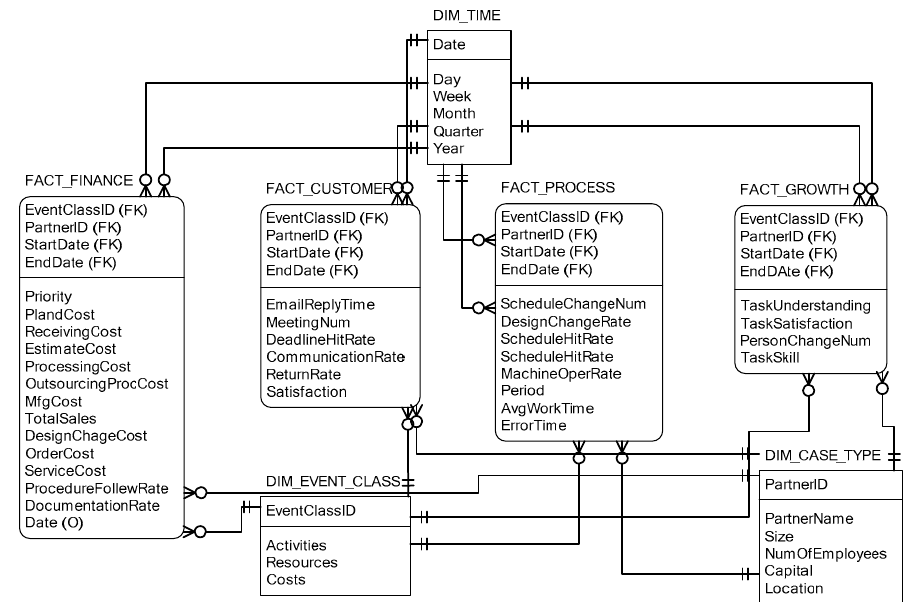
Figure 2. A galaxy schema design for a process warehouse for the collaborative Balanced Scorecard (cBSC) under the Supply Chain Operations Reference (SCOR) models.